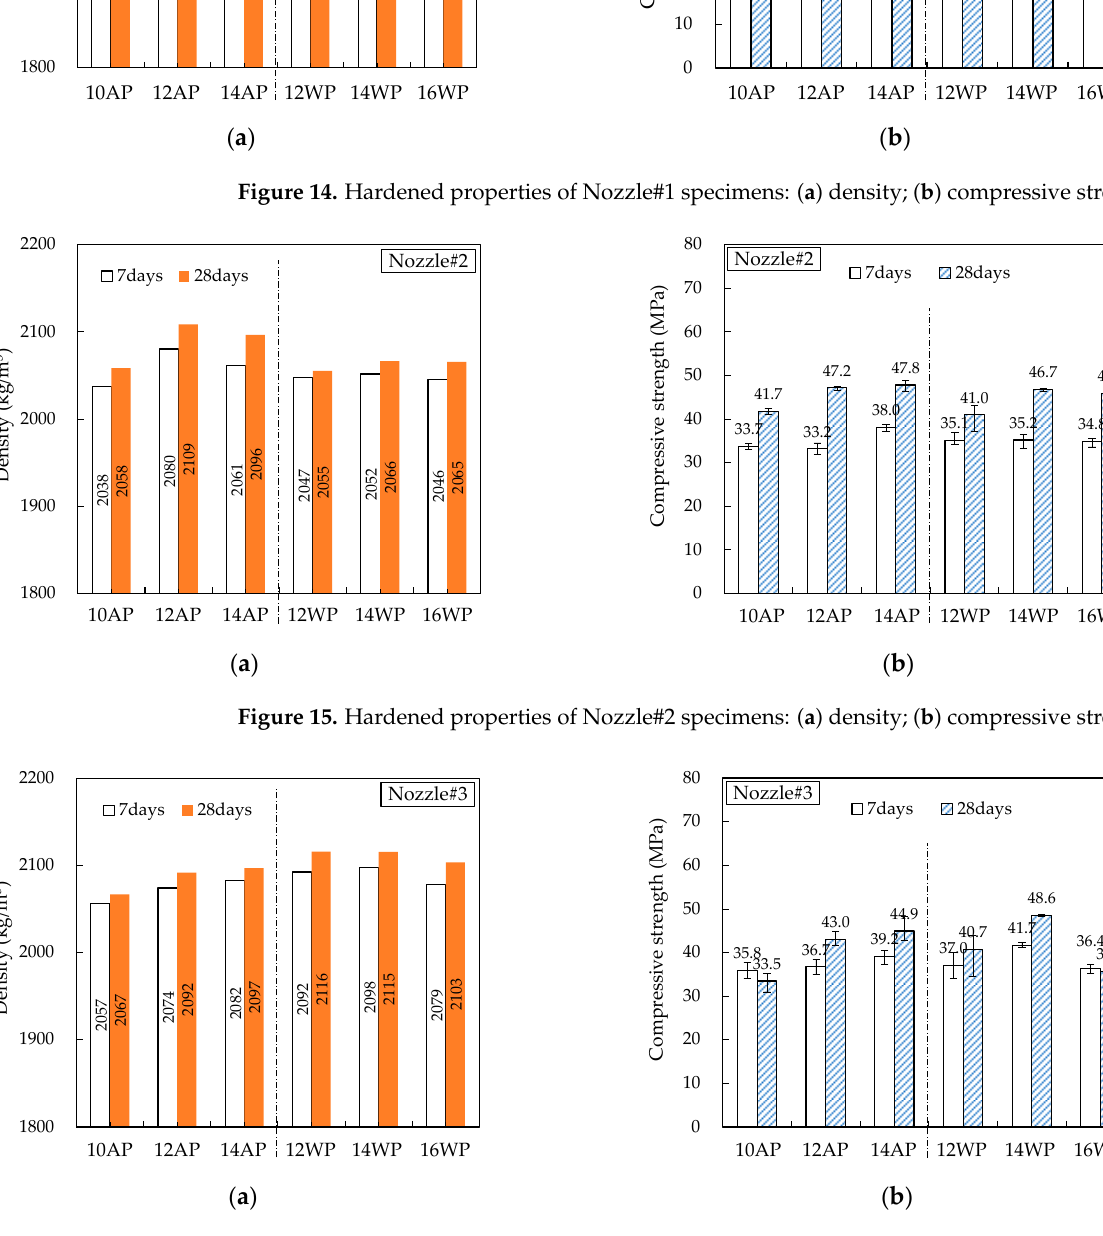
Figure 16. Hardened properties of Nozzle#3 specimens: (a) density; (b) compressive strength.